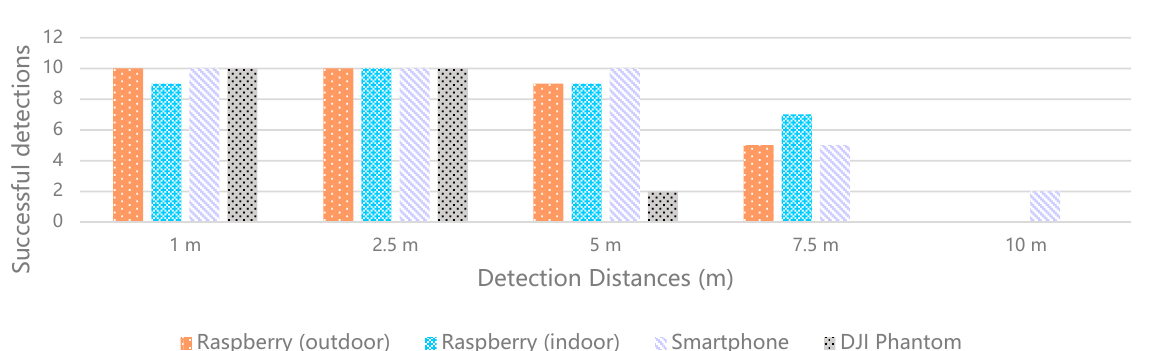
Figure 14. Number of detections (true positives) for distances up to 10 m in each test scenario of Test 1.